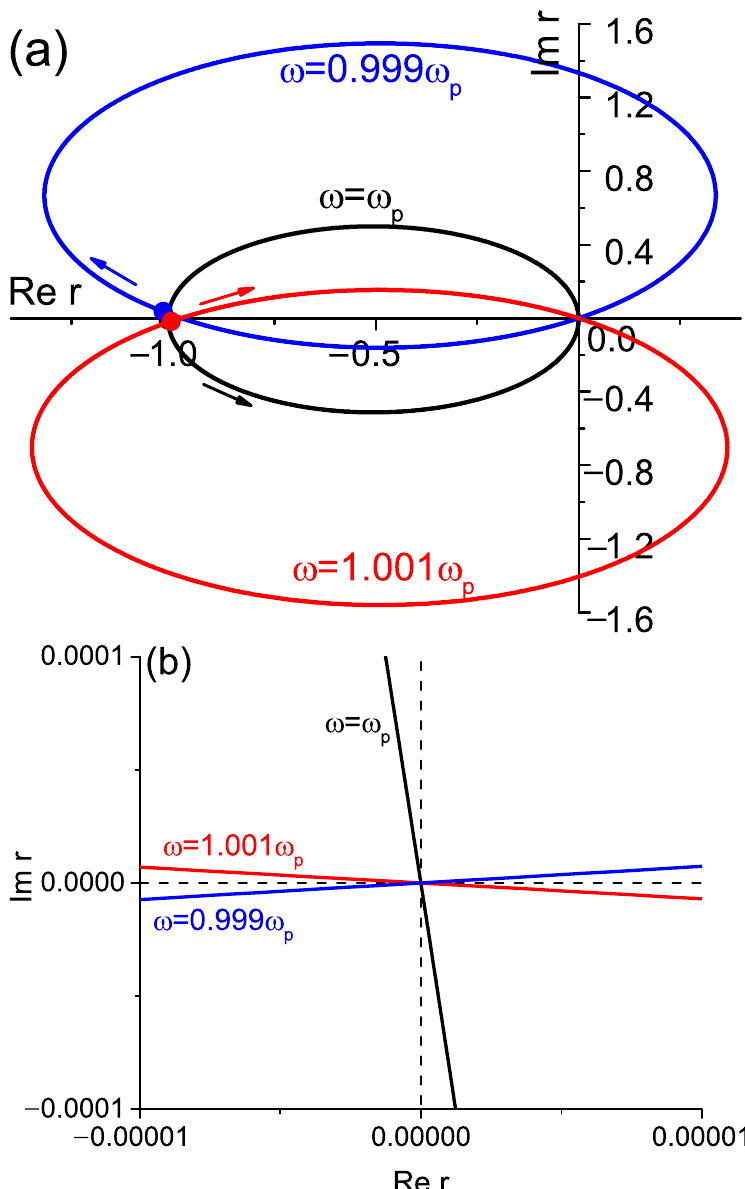
Figure 3. ( a ) The loops of reflection coefficient in the complex frequency plane corresponding to the spectra in Figure 2. The thick dots mark the starting points of the loops, the arrows show the direction of the encircling. ( b ) The close-up of the loops in the vicinity of r = 0. The non-Hermiticity parameter is γ = 10 − 3